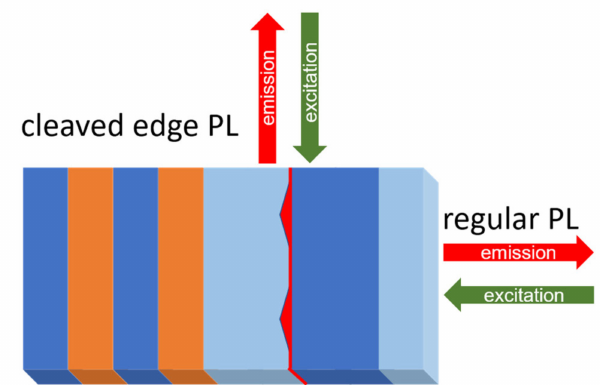
Figure 2. A schematic illustration of regular and cleaved-edge PL. While in regular PL, light emitted from the top of the layer structure is measured, cleaved-edge PL measures the light emitting from the